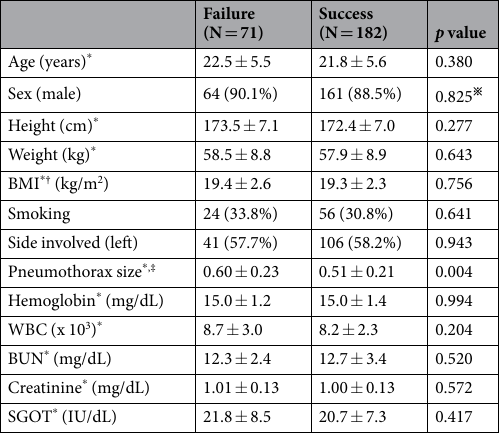
Table 1. Characteristics of successfully treated and treatment failure groups. * Mean ± standard deviation. † BMI = body mass index, WBC = white blood cell count, BUN = blood urea nitrogen, SGOT = serum glutamic- oxaloacetic transaminase. ‡ Estimated by Light index. ※ Using Fisher exact test.